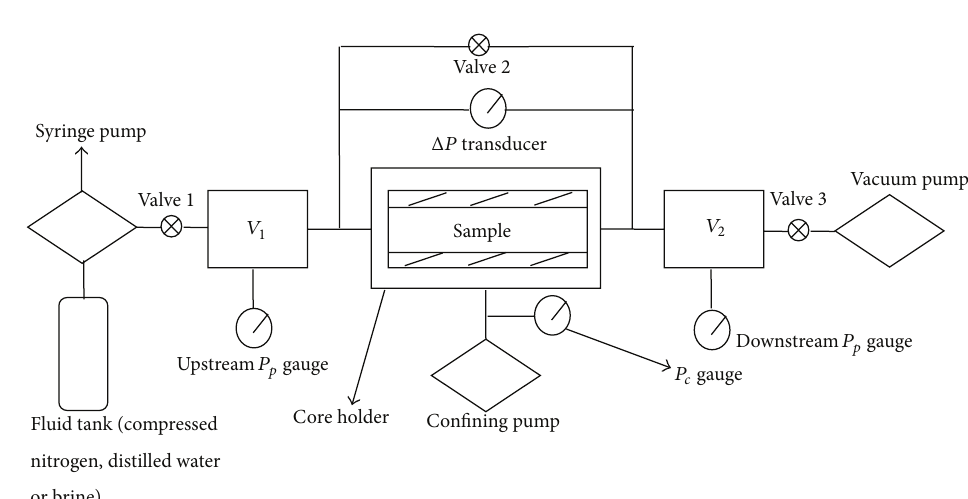
Figure 5: Sketch of the experimental